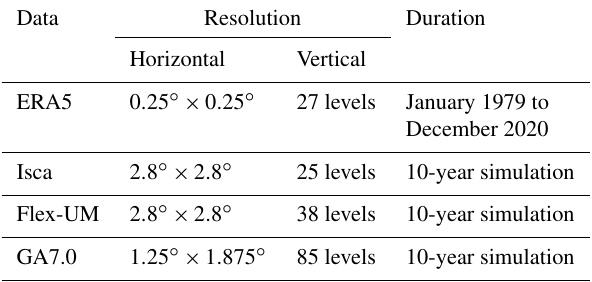
Table 1. Resolution of reanalysis and model data. For ERA5, the vertical levels were limited to 1000–100hPa. For the models, the simulations were run for 20 years and the first 10 years were dis- carded as